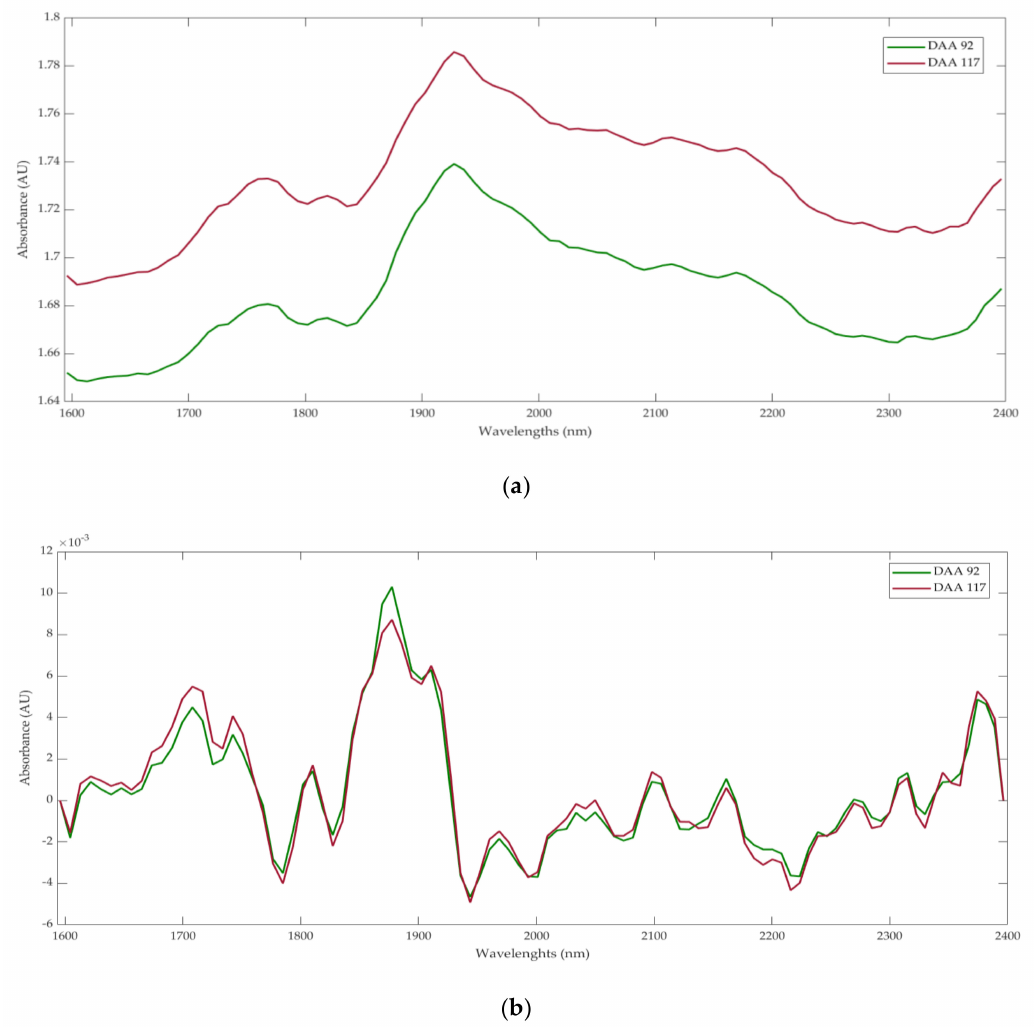
Figure 4. Near-infrared spectroscopy curves using ( a ) the raw absorbance values and ( b ) the first derivative for the 92 and 117 days after anthesis (DAA). Black rectangle in both graphs corresponds to the H 2 O 2 overtones, and grey dotted rectangle to the H 2 O